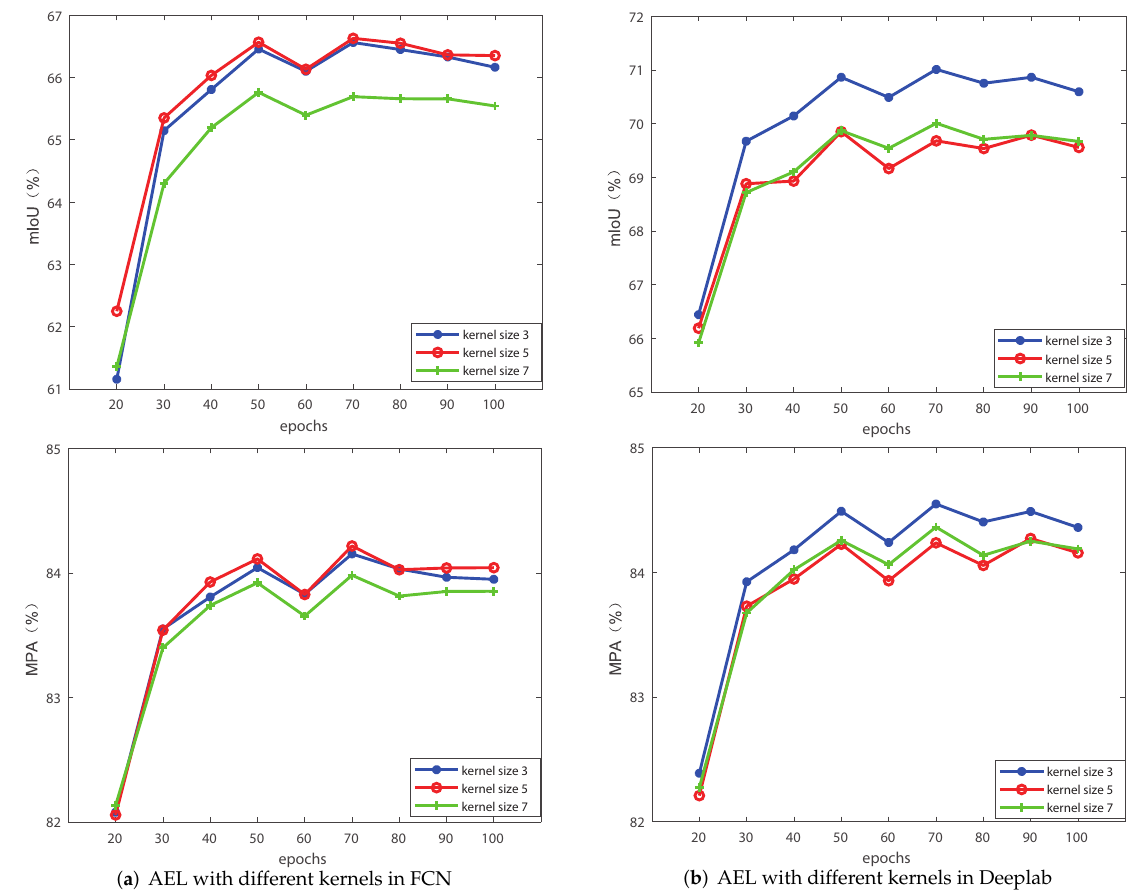
Figure 7. Comparison of different kernels of Adaptive Edge loss on Vaihingen dataset. ( a ) The baseline is FCN. ( b ) The baseline is Deeplabv3. The metrics are mIoU and